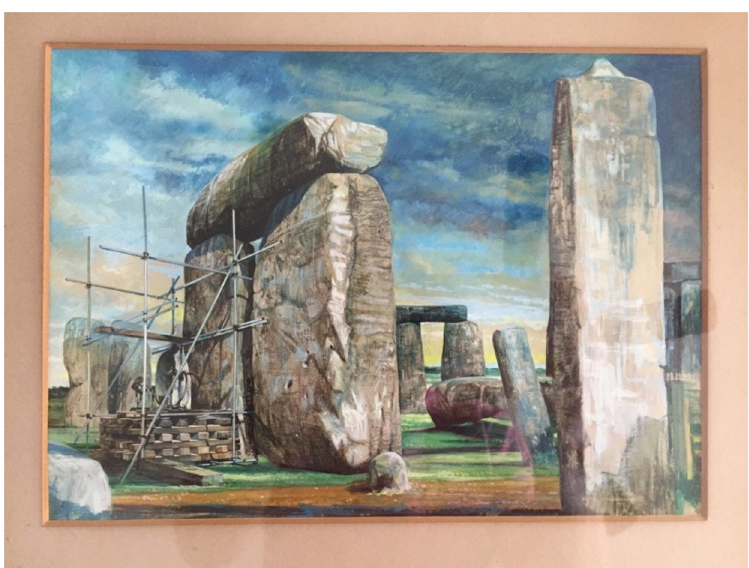
Fig 3. Watercolour painting commissioned by Messrs. L.M. Van Moppes (Diamond Tools) Ltd., now in the possession of the Phillips family, showing coring operations on Stone 58 of Stonehenge in 1958. This image is reproduced under a CC BY 4.0 license, with permission from Lewis Phillips, original copyright (2018).